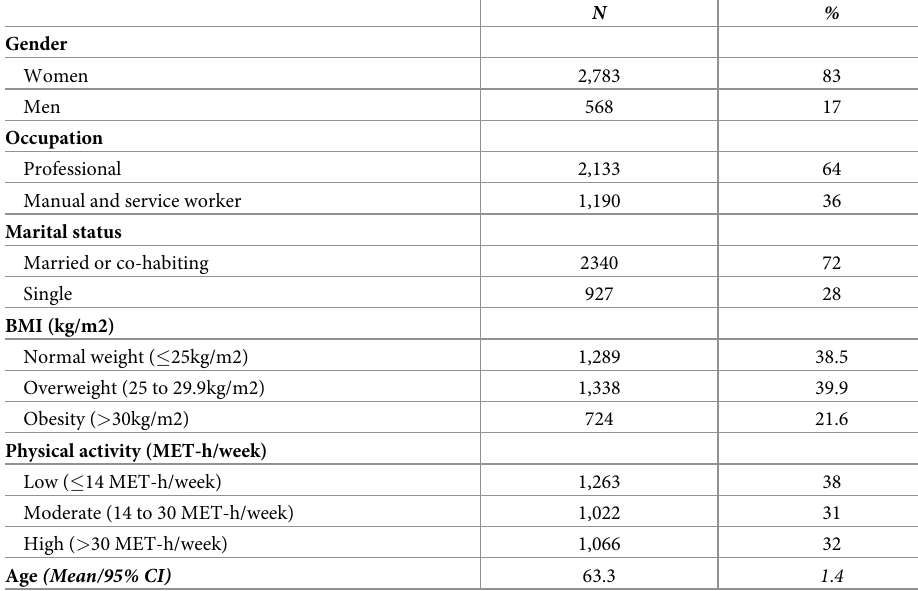
Table 1. Characteristics of the study population at pre-retirement (wave